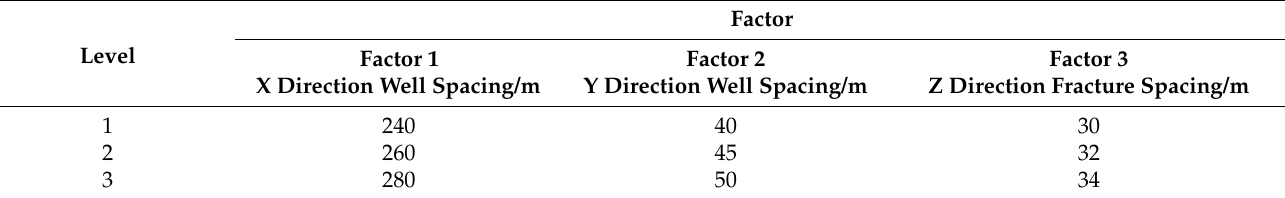
Figure 15. Mean value graph of each factor in deviated well. Table 8. Orthogonal design table for vertical wells.